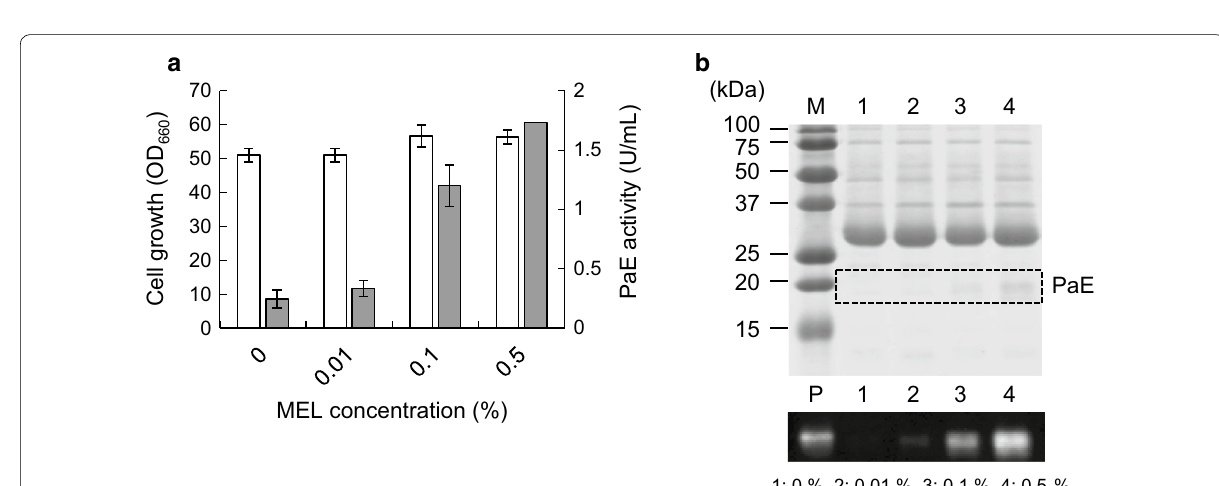
Fig. 5 PaE production by strain ∆Pa EMT1 in m -3 FMM medium supplemented with 8% xylose and various concentrations of MEL. a Cell growth × (white) and PaE activity (gray). b SDS-PAGE and western blot analysis of culture supernatant. M, marker; P, purified PaE. The amount of each culture supernatant loaded in the gel was 10 μL for CBB staining and western blotting. The results of the cell growth and PaE activity assays are shown as the average of three different experiments. Error bars show standard